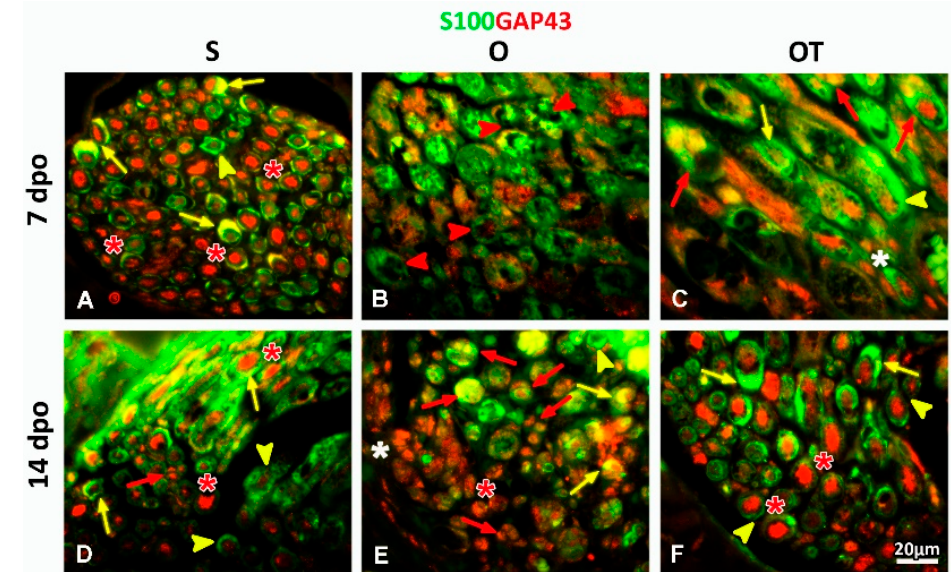
Figure 5. GAP43 (growth associated protein 43) expression in SCs and axons after PNI and the treatment with B vitamins. Expression of GAP43 (red) in SCs was determined in the femoral nerve cross sections obtained from the: sham (S), operated (O) and operated and treated with the vitamin B (B1, B2, B3, B5, B6, and B12) complex (OT) group at the 7th and 14th dpo. Anti-S100 antibody (green) was used as a marker of SCs. In the S group, both at the 7th ( A ) and the 14th ( D ) dpo GAP43 immunostaining was mostly detected in large-diameter myelinated axons (red asterisk), and in a few myelinated S100 + /GAP43 + (yellow arrows) and non-myelinated SCs (red arrows), while S100 + /GAP43 − (yellow arrow heads) SCs were predominant. ( B ) In the O group, at the 7th dpo most of the axons were destroyed and the majority of SCs degenerated (red arrow heads). ( C ) 7 consecutive injections of B vitamins (OT) increased the number of non-myelinating S100 + /GAP43 + SCs (red arrows) wrapping multiple small-diameter GAP43 + non-myelinated axons (white asterisk). Only a few S100 + /GAP43 + myelinated SCs (yellow arrows) and S100 + /GAP43 - (yellow arrow heads) were seen. ( E ) At the 14th dpo, in the O group, a huge number of S100 + /GAP43 + non-myelinated SCs (red arrows) unsheathing multiple small-caliber axons (white asterisk), and a paucity of myelin-forming S100 + /GAP43 + (yellow arrows) and S100 + /GAP43 − (yellow arrow heads) SCs was detected. ( F ) After 14 treatments with B vitamins myelinating, mature S100 + /GAP43 − SCs emerged as the principal cell type (yellow arrow heads), while S100 + /GAP43 + myelinating SCs were rarely present (yellow arrows). Strong GAP43 immunostaining was detected in large-diameter myelinated axons (red asterisk). Scale bar: 20 µm.